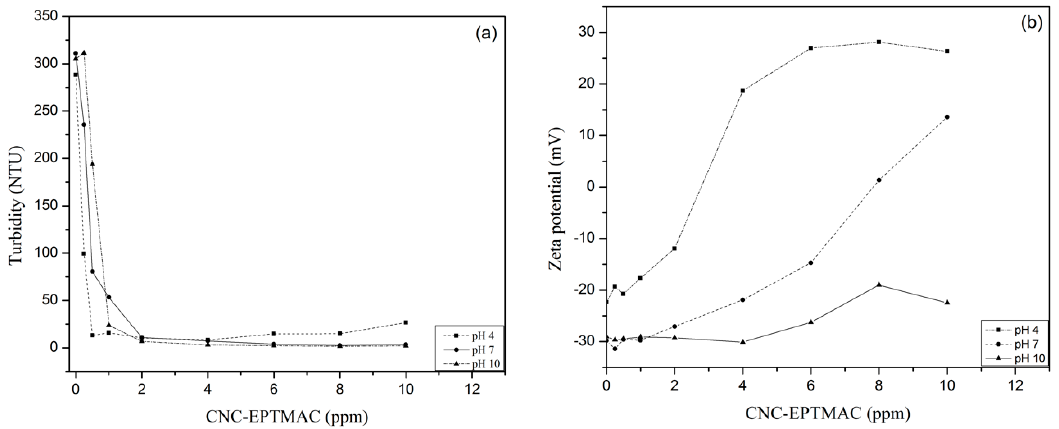
Figure 8. Effect of pH (acid pH 4, neutral pH 7 and alkaline pH 10 ) on flocculation. ( a ) Turbidity and ( b ) Zeta potential change.